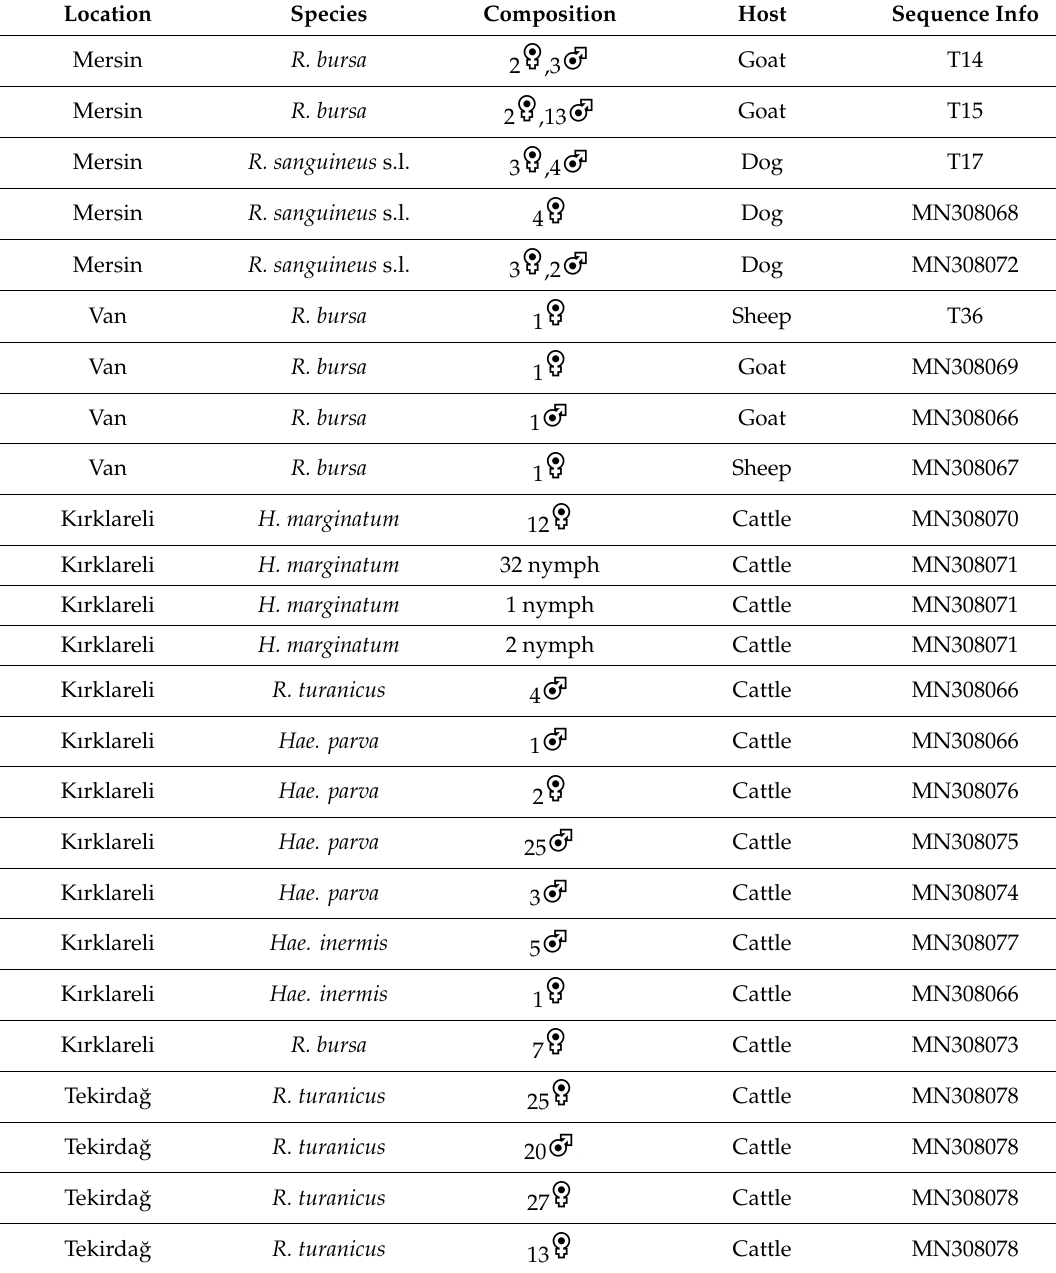
Table 1. Tick pools with detectable Jingmen tick virus (JMTV) sequences.